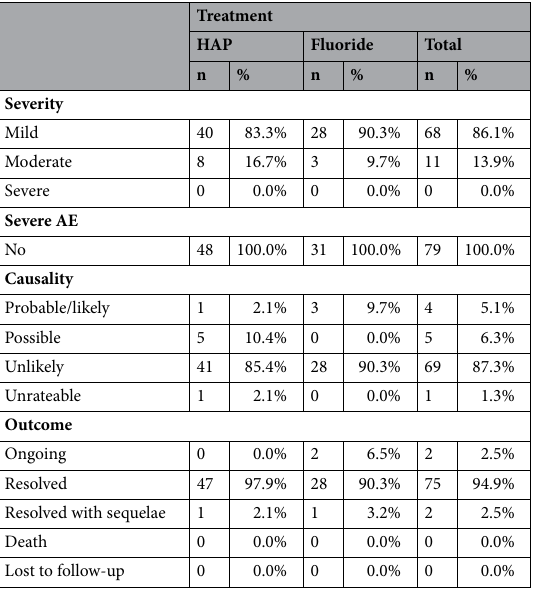
Table 8. Overview of severity, causality, and outcome of adverse